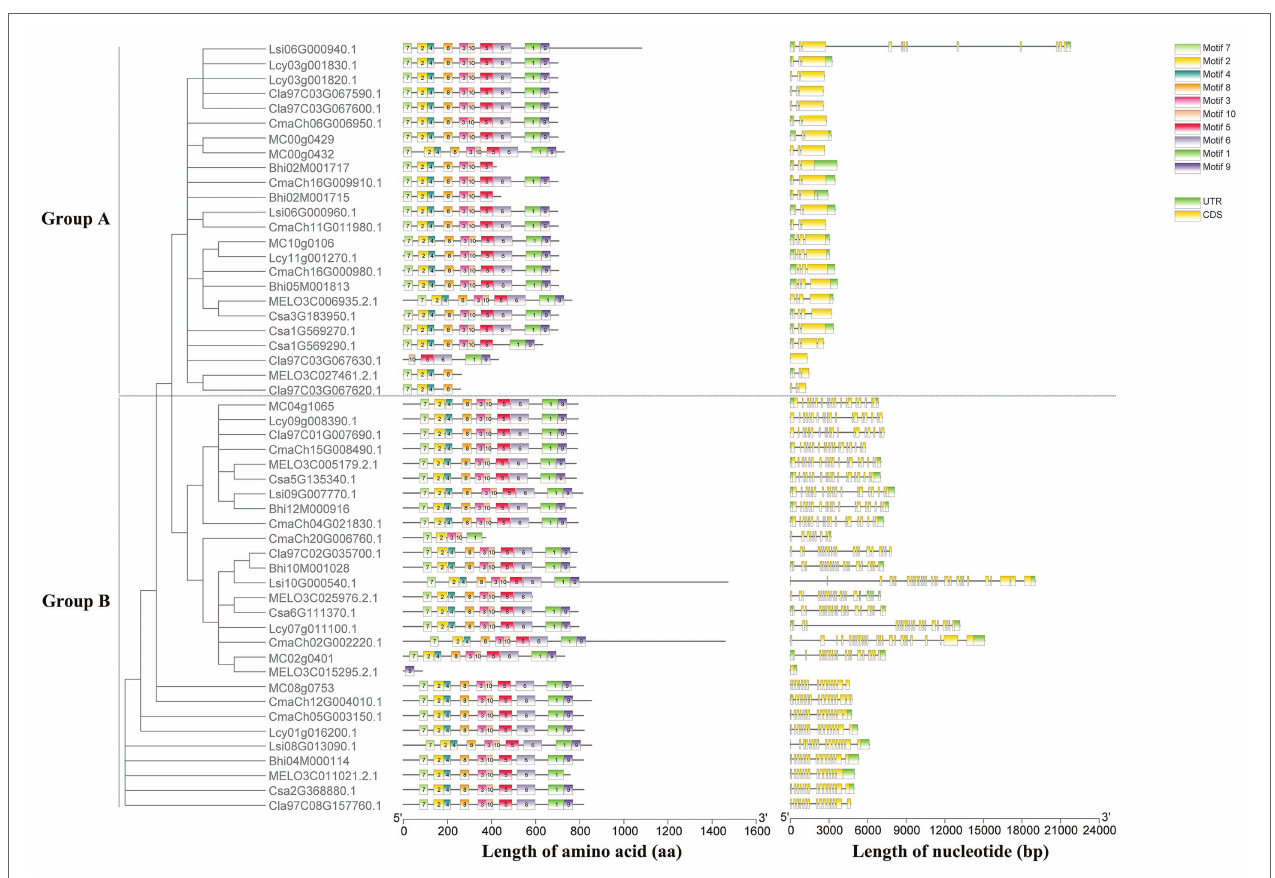
FIGURE 2 | Phylogenetic tree, conserved motifs of HSP90 proteins, and exon/intron structures of HSP90 genes in the eight Cucurbitaceae